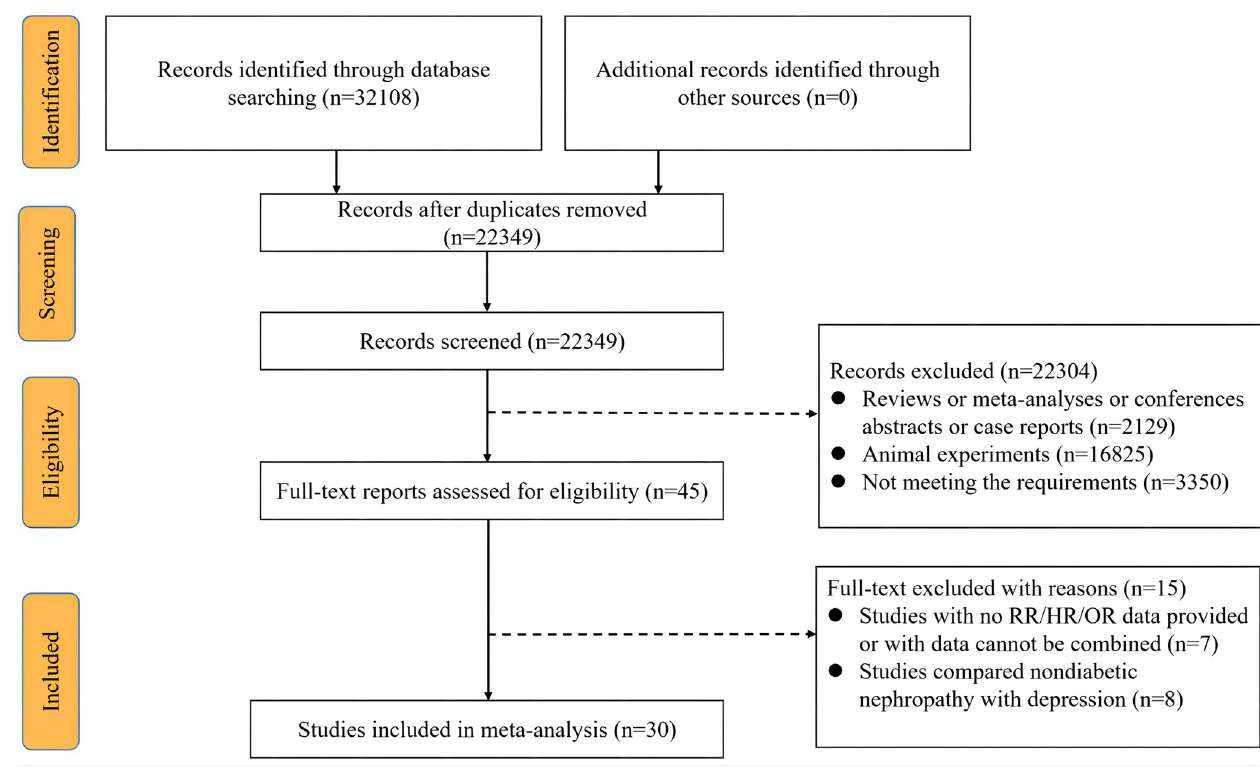
Fig 1. Systematic review flow